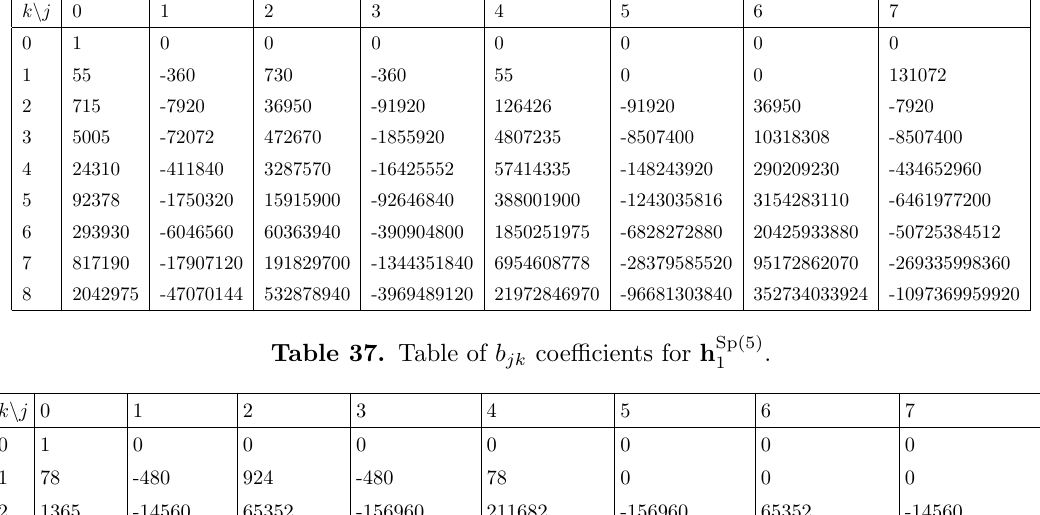
Table 37. Table of b jk coe(cid:14)cients for h Sp(5)